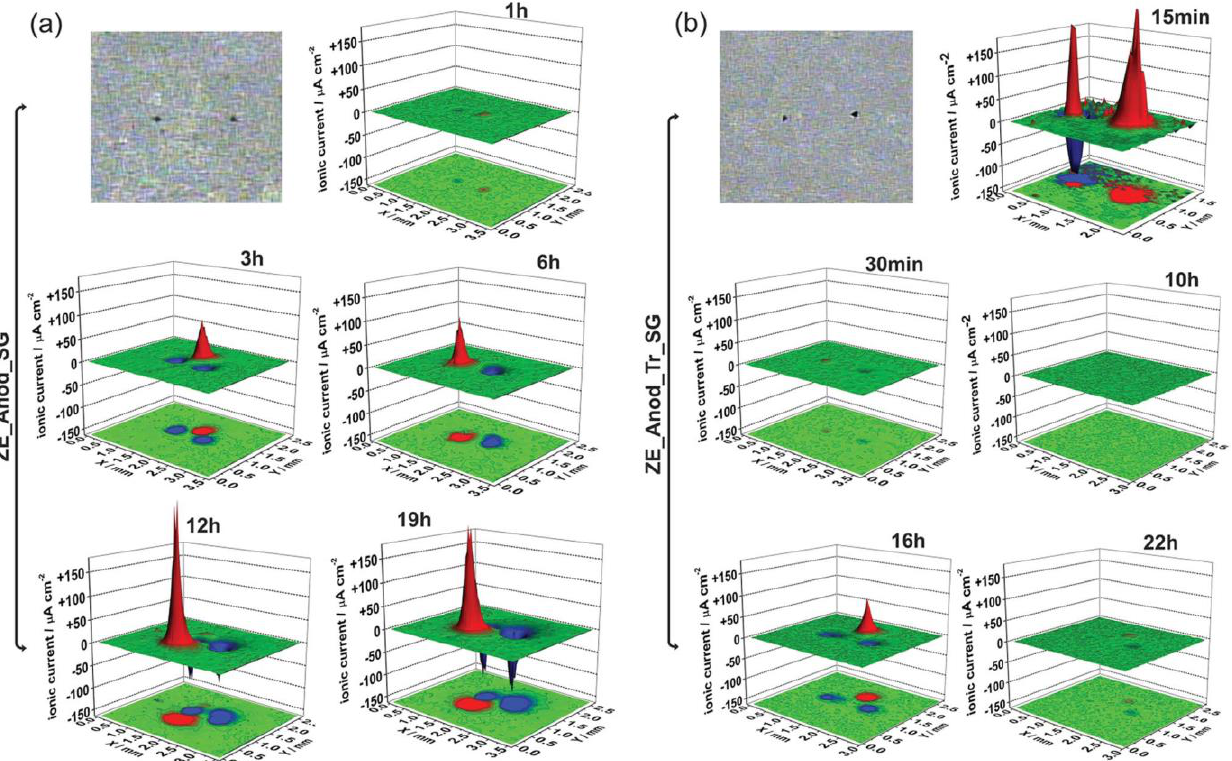
Figure 23. Microphotograph of scanned area and distribution of ionic currents (measured by SVET) for the ZE41 magnesium alloy coated with composite film after different immersion time in 0.05M NaCl solution ( a ) without loaded 1,2,4 triazole and ( b ) with loaded 1,2,4 triazole. Adapted and reprinted from [76].